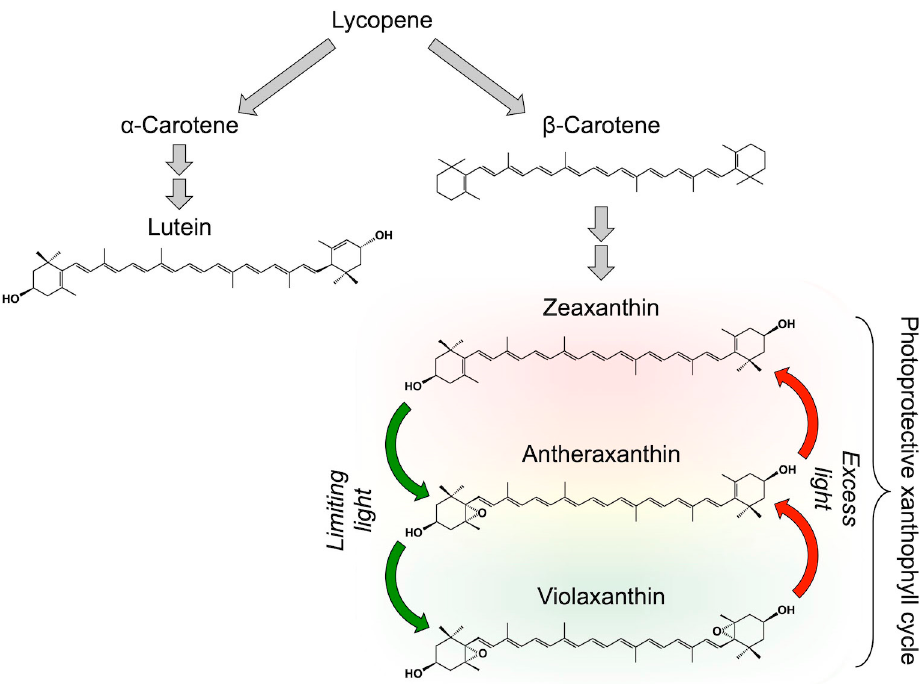
Figure 1. Schematic depiction of the synthesis from lycopene (which does not accumulate in leaves) of foliar carotenoids α -carotene, lutein, β -carotene, and zeaxanthin, as well as interconversions of zeaxanthin, antheraxanthin, and violaxanthin in the xanthophyll cycle.